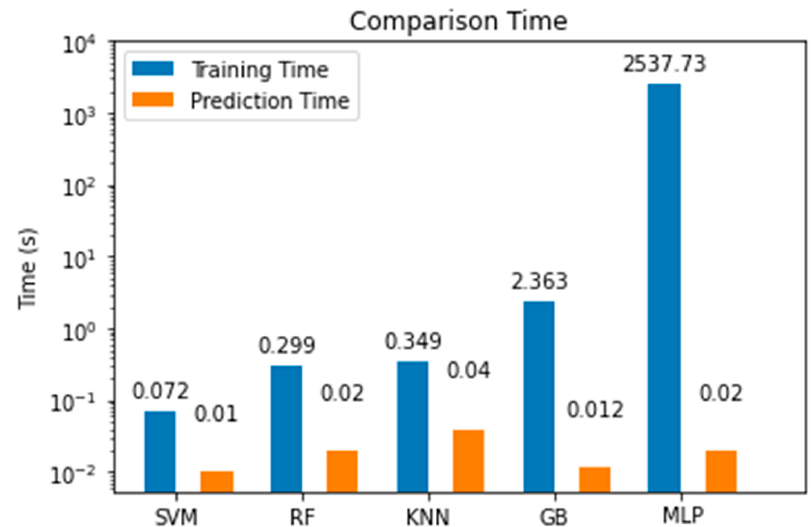
Figure 13. Comparison of the accuracy achieved for the training and validation data by the MLP model against other machine learning models. Figure 15. Comparison of training and estimation time for the MLP model against other machine learning models.